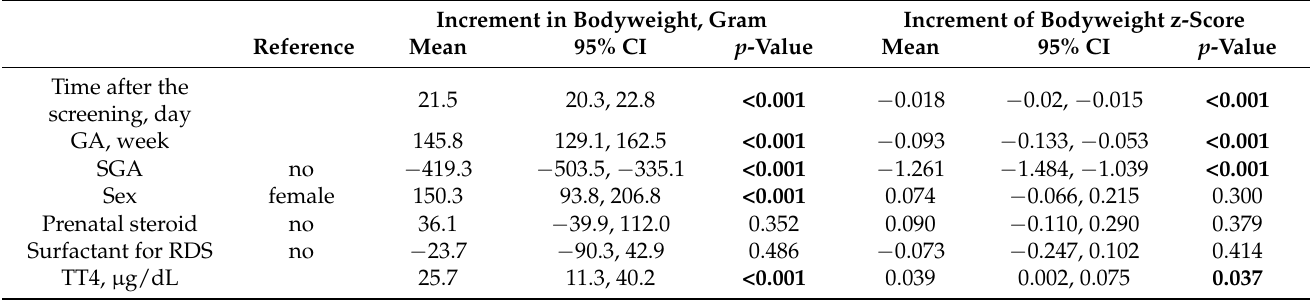
Table 2. The association between the thyroxine concentration at 1 month old and the outcomes for the following 28-day increments of body weight and body weight z-score (multivariate analysis). Increment in Bodyweight, Gram Increment of Bodyweight z-Score Reference Mean 95% CI p -Value CI: confidence interval; GA: gestational age; SGA: small for gestation age; RDS: respiratory distress syndrome; TT4: total serum thyroxine. Multivariate analysis by generalized estimating equations was performed for each dependent variable and independent variable. Statistical significance was assumed for p < 0.05 (indicated in bold).